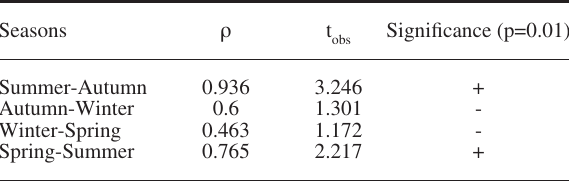
Table 12. – statistical variations of the diet of P. acarne adults in relation to season. ρ , spearman coefficient of correlation; t student test values; (+), homogeneous diet; (-), heterogeneous